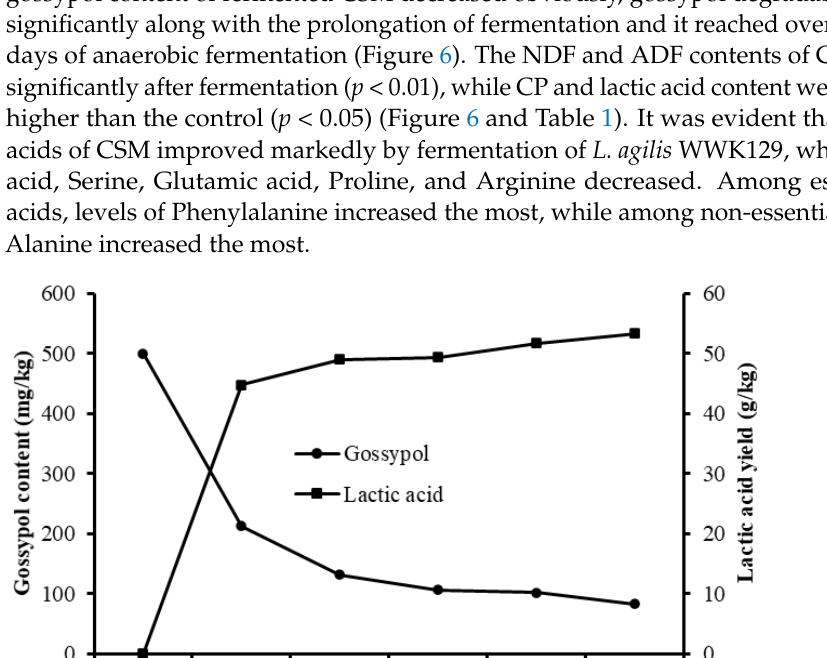
Figure 5. Growth curve of L. agilis WWK129 in carbon source of gossypol and glucose. OD600, optical density of incubated medium at 600 nm.